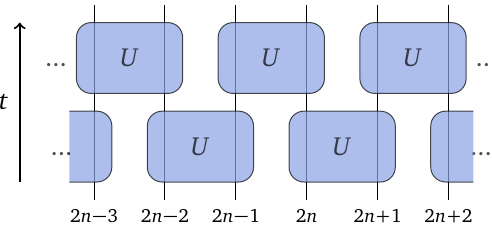
Figure 1: One time step of the discrete time evolution of an observable, represented by the propagator U = U